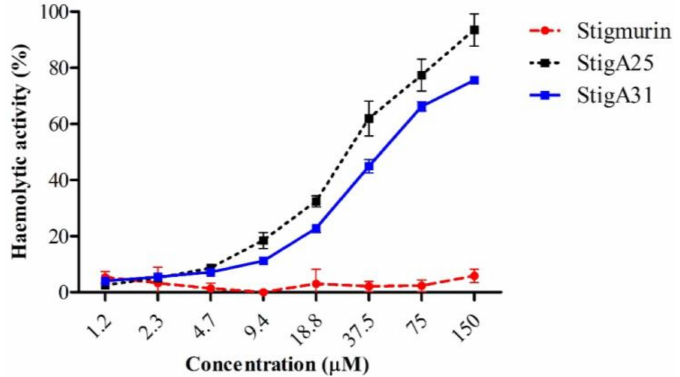
Figure 8. Hemolytic activity percentage of Stigmurin, StigA25, and